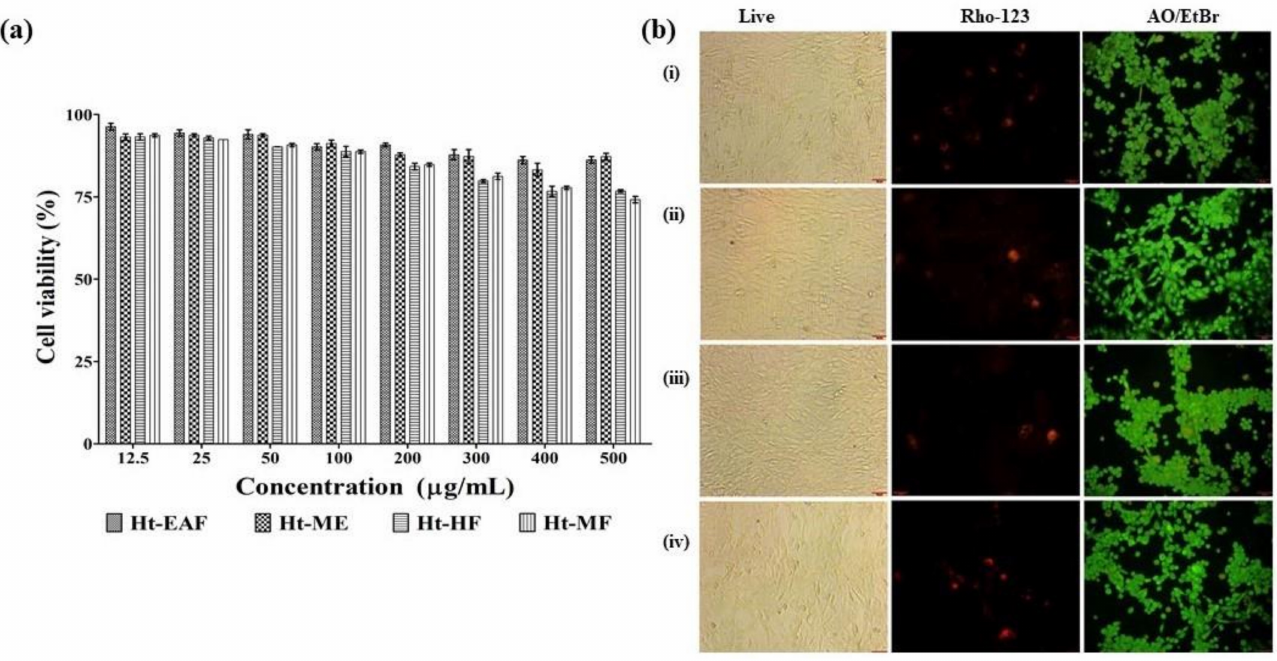
Figure 2. ( a ) % of cell viability of different fraction and methanolic extracts of H. tuberosus . ( b ) Biocompatibility of HT-EAF was screened by light microscopic, rhodamine 123, and dual staining. (i) CK, (ii) 12.50 µ g/mL of Ht-EAF (iii) 200 µ g/mL of Ht-EAF (iv) 500 µ g/mL of Ht-EAF. The values are expressed as mean ± standard deviation of three independent